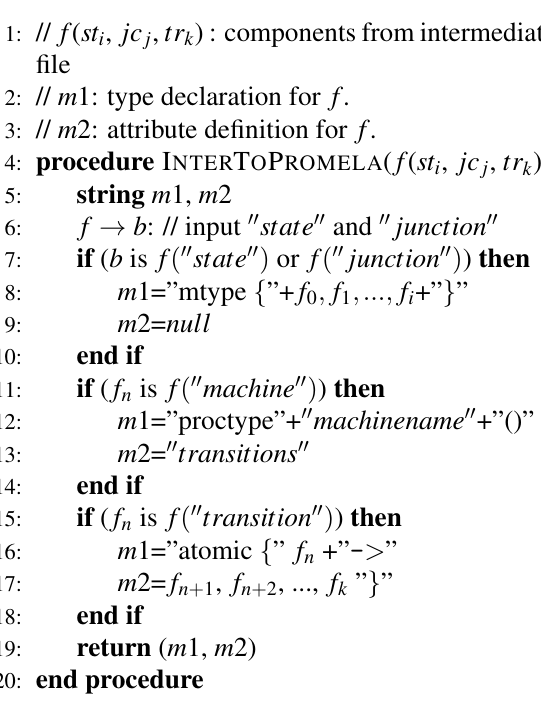
Fig. 7. Intermediate file to P